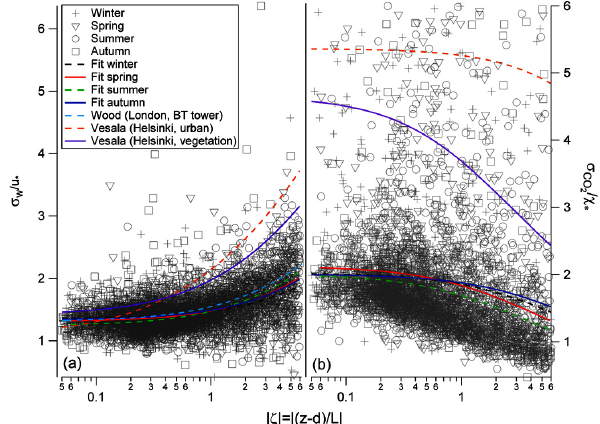
Fig. 4. Normalised standard deviation of (a) w and (b) [CO 2 ], as a function of seasonal stability ( ζ < 0, unstable; NB: the absolute value of ζ is used in the graph). The fit obtained by Wood (Wood et al., 2010a) using 2007/2008 tower data (Fig. 4a only) and regression results for two land-use classes (urban and vegetation) in Helsinki (Vesala et al., 2008) are also